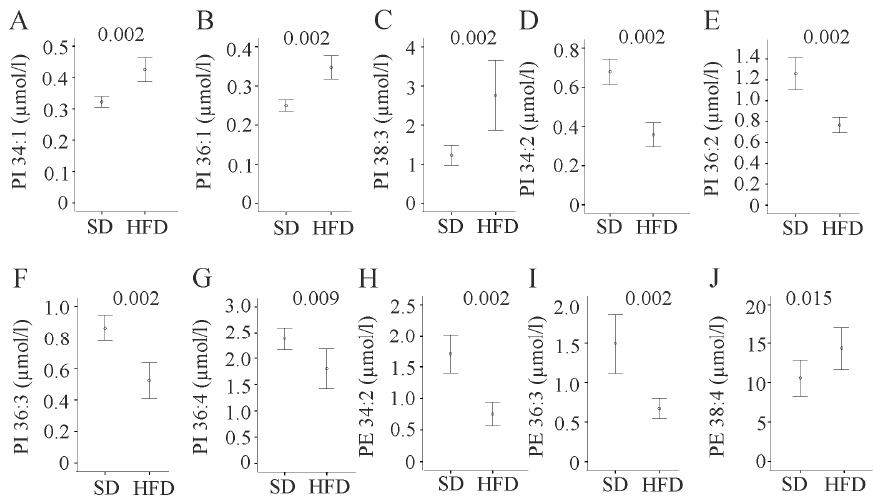
Figure 3. Phosphatidylinositol (PI) and phosphatidylethanolamine (PE) species in serum of mice fed a standard chow (SD) or high fat diet (HFD) for 14 weeks. ( A ) PI 34:1;